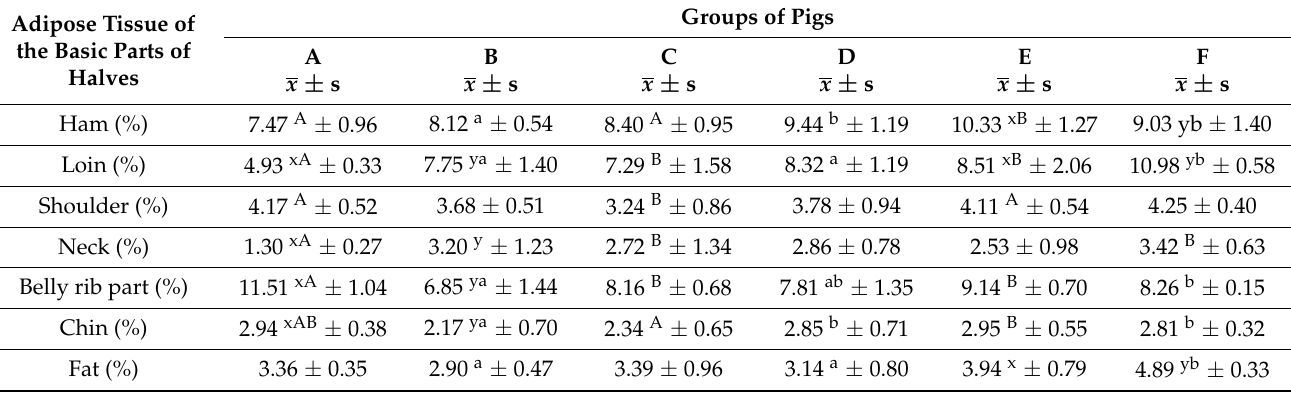
Table 7. Shares of adipose tissue of the basic parts in the weight of the pig